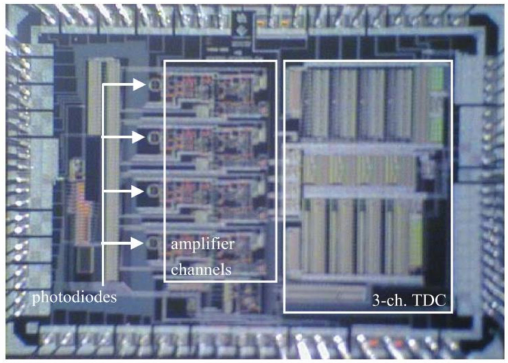
Figure 13. Microphotograph of multichannel LiDAR receiver design [89].